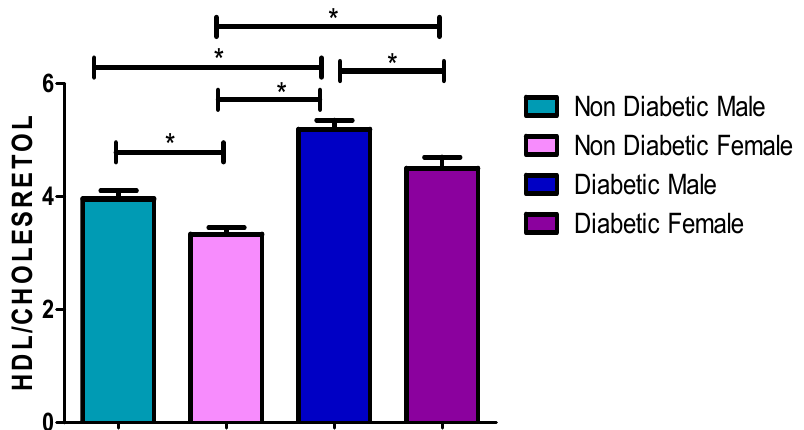
Figure 6. Cholesterol / HDL-C ratio. *, a significant statistical di ff erence ( p -value < 0.05). The statistical bar ( ) shows the relationship between the four variables: there was a significant statistical di ff erence in the Cholesterol / HDL-C ratio between the non-diabetic female and diabetic female, the non-diabetic male and diabetic male, the diabetic male and diabetic female, the non-diabetic female and diabetic male, and between the non-diabetic male and non-diabetic female, respectively.